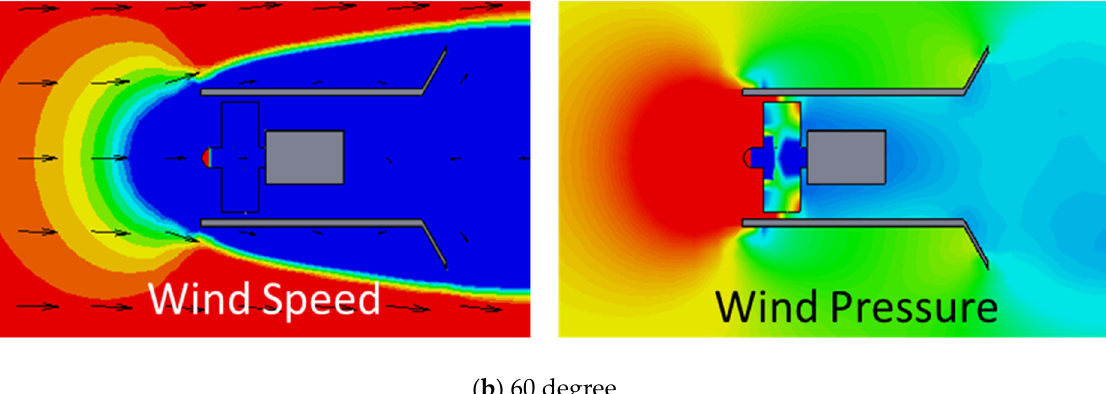
Figure 5. Wind speed (m/s) and pressure (Pa) for the brim angle at the outlet (the legends are identical to those in Figure 2 and omitted here).